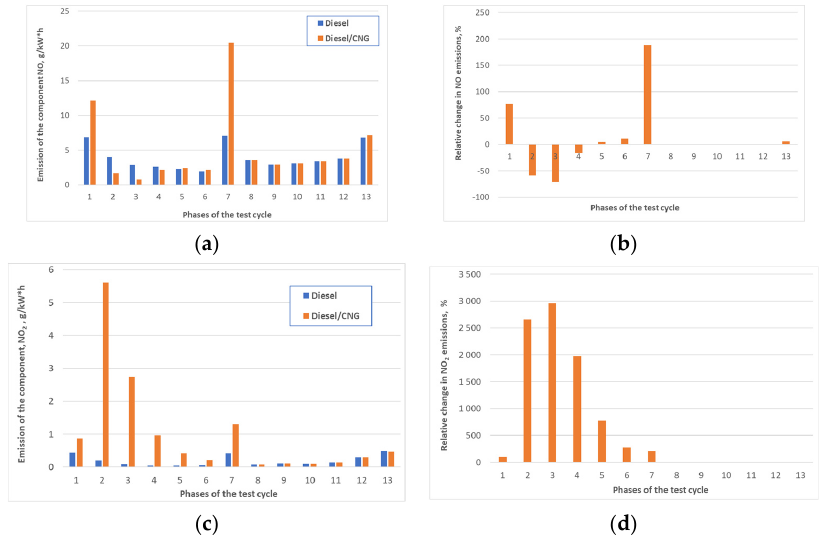
Figure 14. Emission of gaseous exhaust components during test on diesel fuel and diesel/CNG supply for individual phases of the test: ( a ) emission of NO, ( b ) relative change in NO emission, ( c ) emission of NO 2 and ( d ) relative change in NO 2 emission.